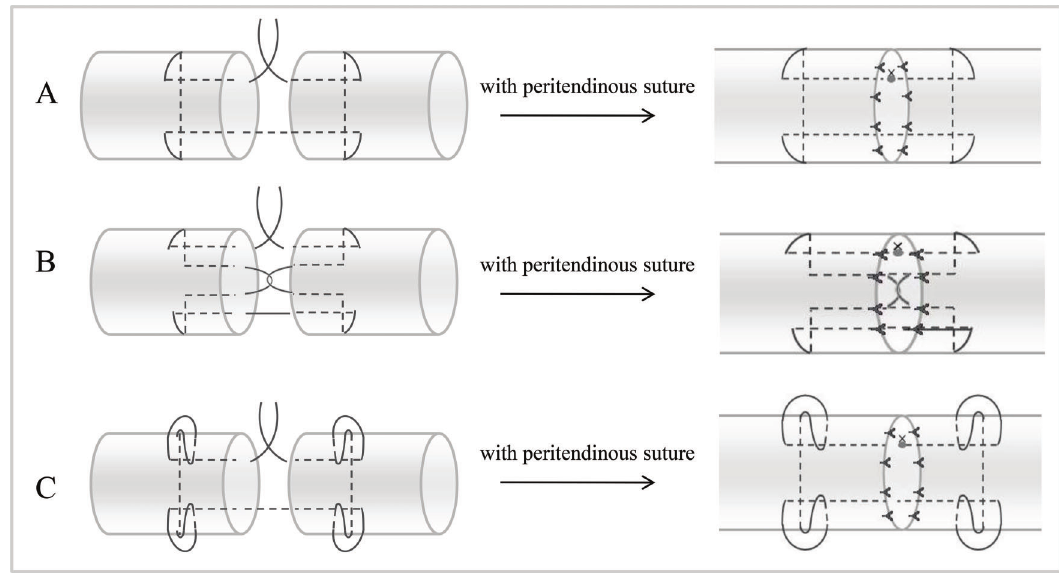
Figure 1 - Various suture techniques used for mechanical testing. A. Modified Kessler suture with peritendinous suture (MK); B. Interlock suture with peritendinous suture (IS); C. Modified Kessler-loop lock suture with peritendinous suture (MKL).